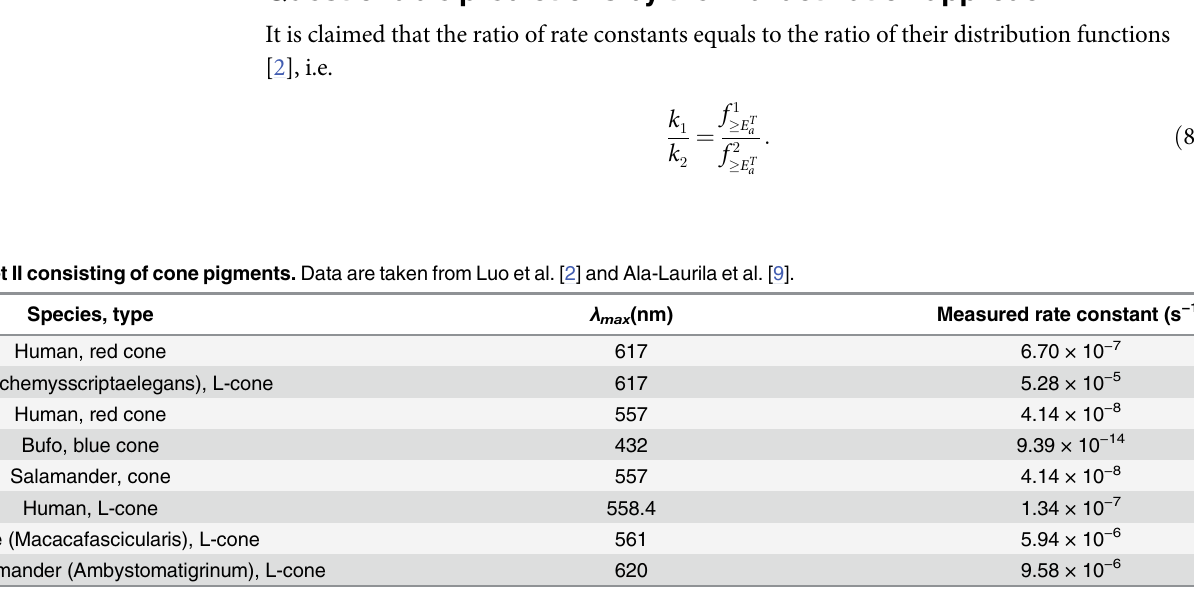
confidence bound of the fitting procedure. The functions were plotted in Fig 1 with a linear scale (a, b) as well as with a logarithmic one (c, d). If we apply the average of m values, 42 and 49, as m = 45 with a single A value for a com- bined datasets I and II for both rod and cone cells then the amount of deviation from experi- mental data will be very large. To check this high deviation please see the predictions of their theory in the following section. As a result, rod and cone cells should be investigated separately with different m values.